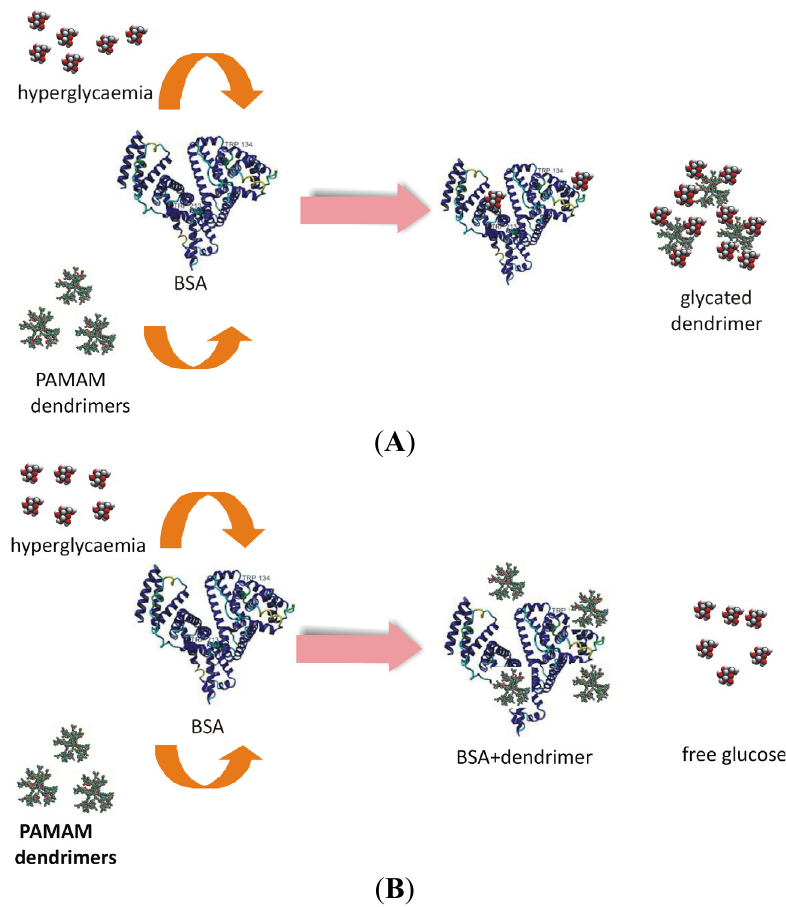
Figure 15. Two hypothetical pathways of PAMAM dendrimer interactions with albumin that could result in reduced albumin glycation. ( A ) The attachment of glucose to albumin free primary amino groups (albumin glycation) is hampered by PAMAM dendrimers, which scavenge the glucose and undergo glycation themselves. ( B ) PAMAM dendrimers interact with albumin molecules, which thereby become less susceptible to